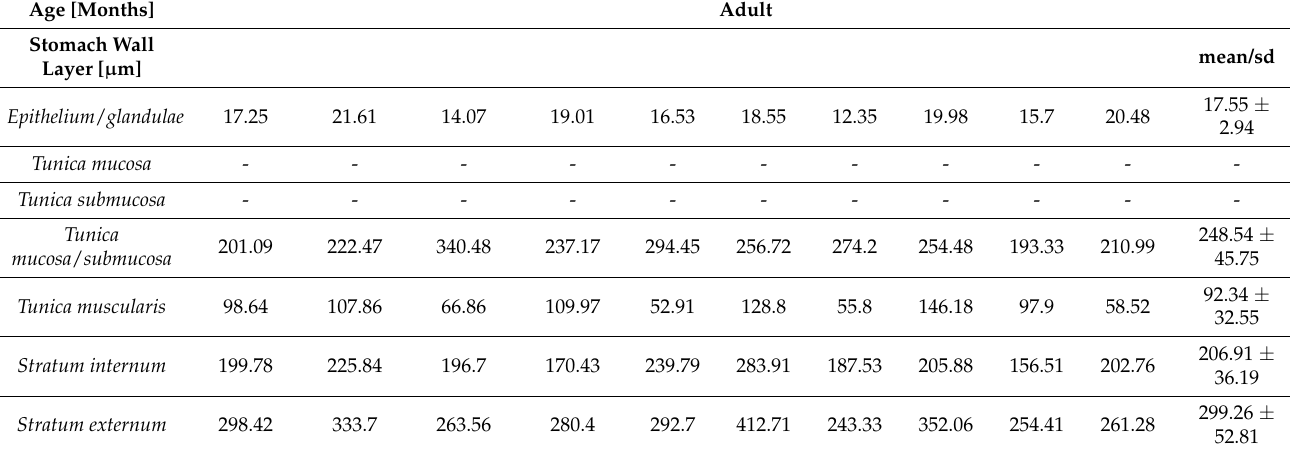
Table 4. Histometry of equine stomach—the blind ventricular sac ( saccus caecus